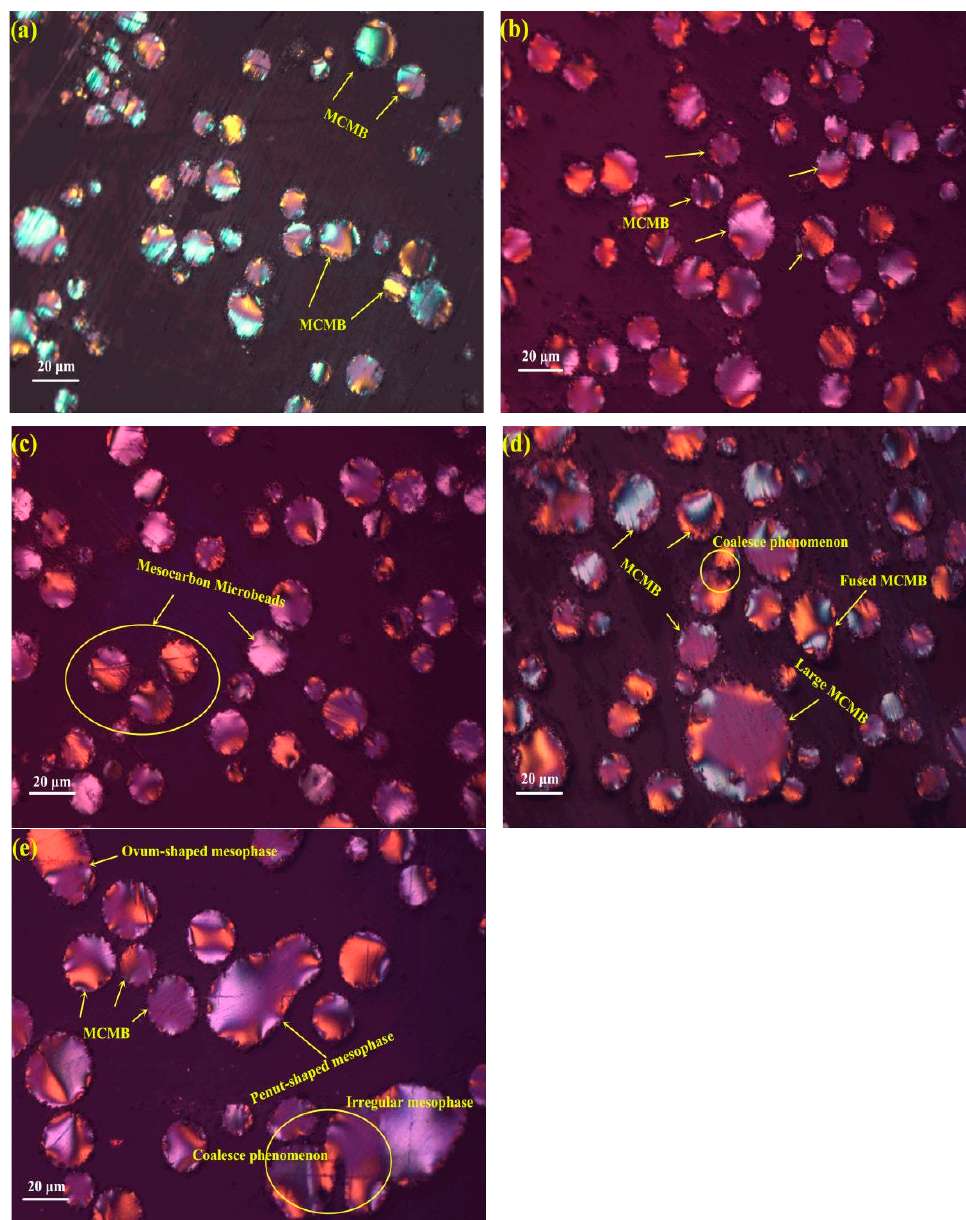
Figure 3. Optical microstructure of MCMBs: ( a ) MCMB-g-0%, ( b ) MCMB-g-1.5%, ( c ) MCMB-g-3%, ( d ) MCMB-g-5%, and ( e ) MCMB-g-7%.